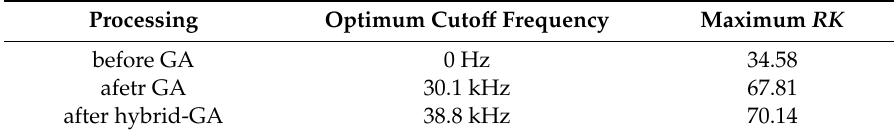
Table 2. Optimum cutoff frequencies and RK s in outer race flaw data at CH1.